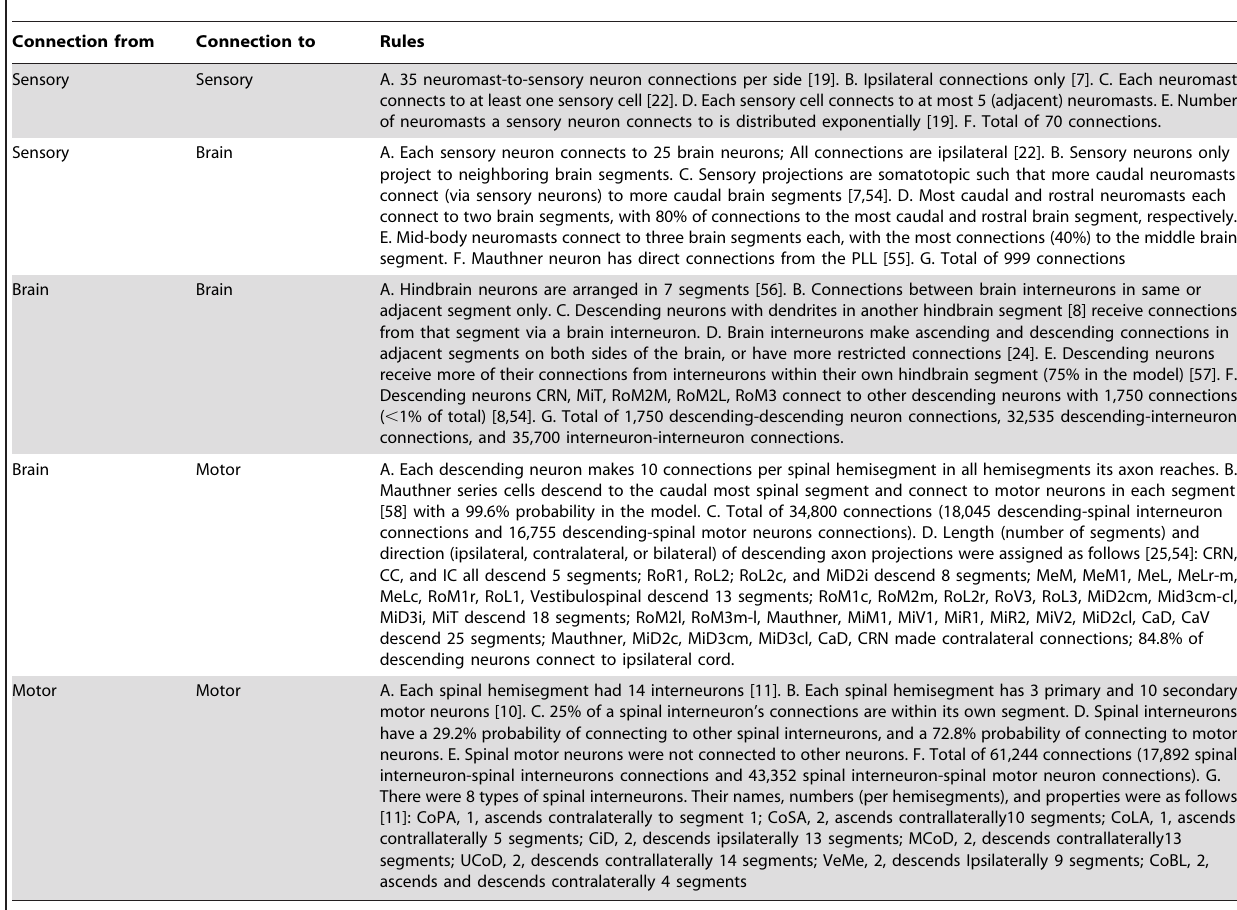
Table 1. Rules governing distribution of connections in the zebrafish model